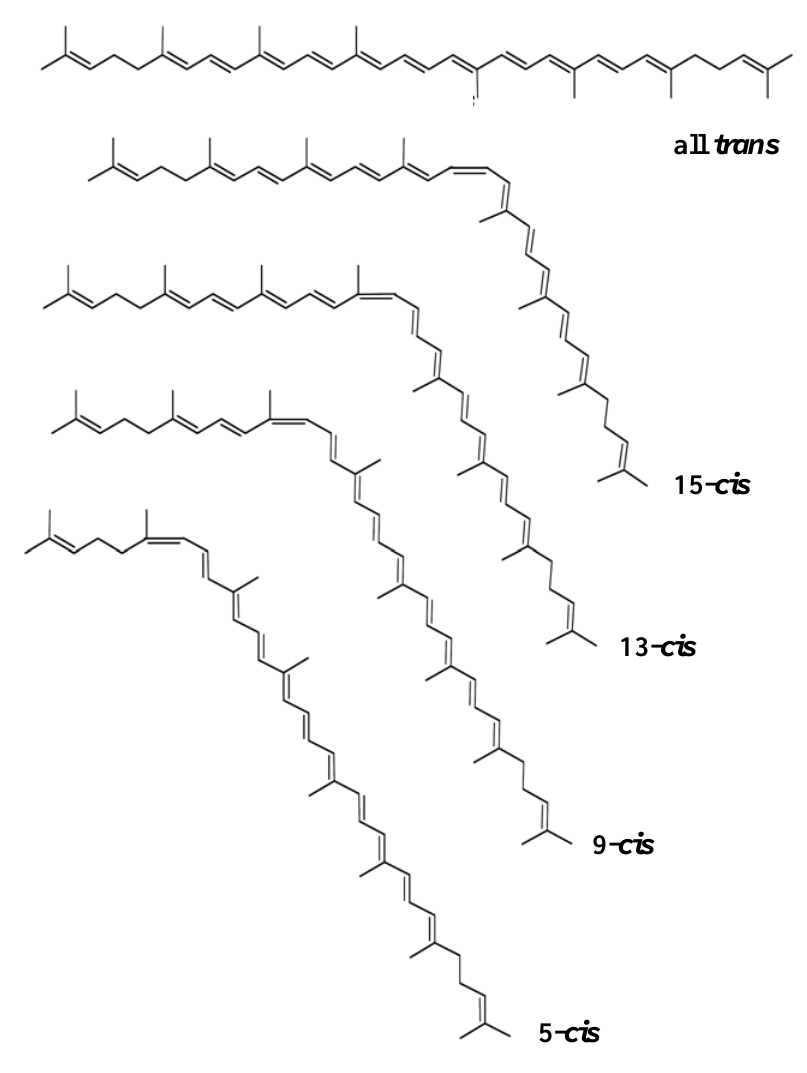
Source: Agarwal and Rao